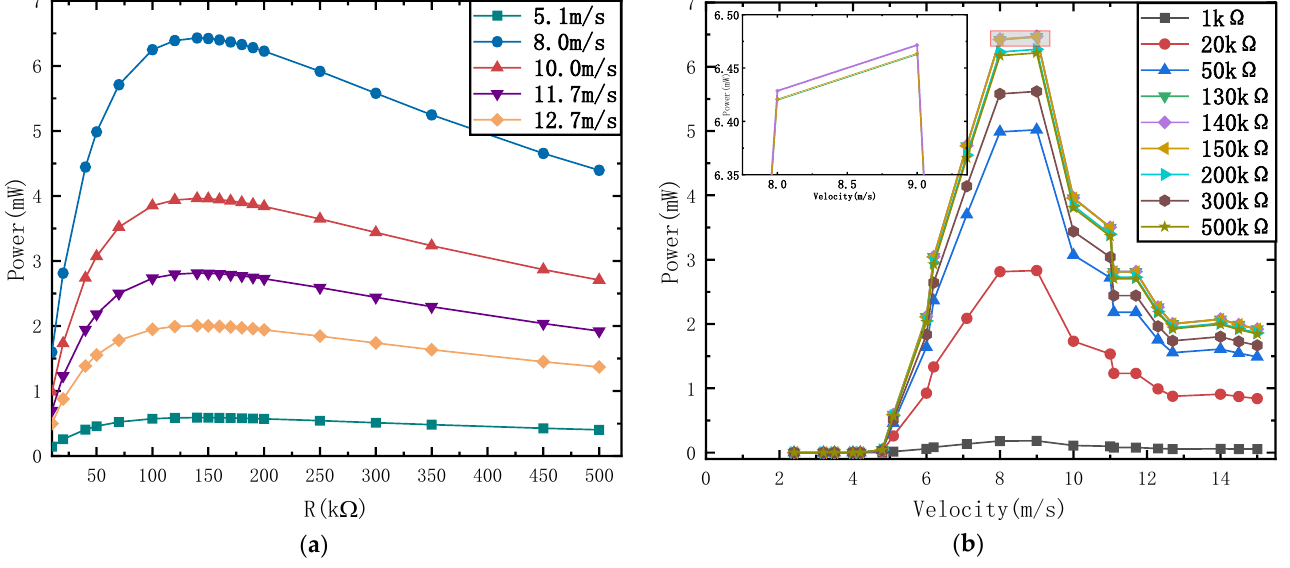
Figure 4. Influence of key parameters on the output power of the VFPEH-30: ( a ) Curves of the output power with load under different wind velocities; ( b ) Curves of output power with the wind velocity under different loads.